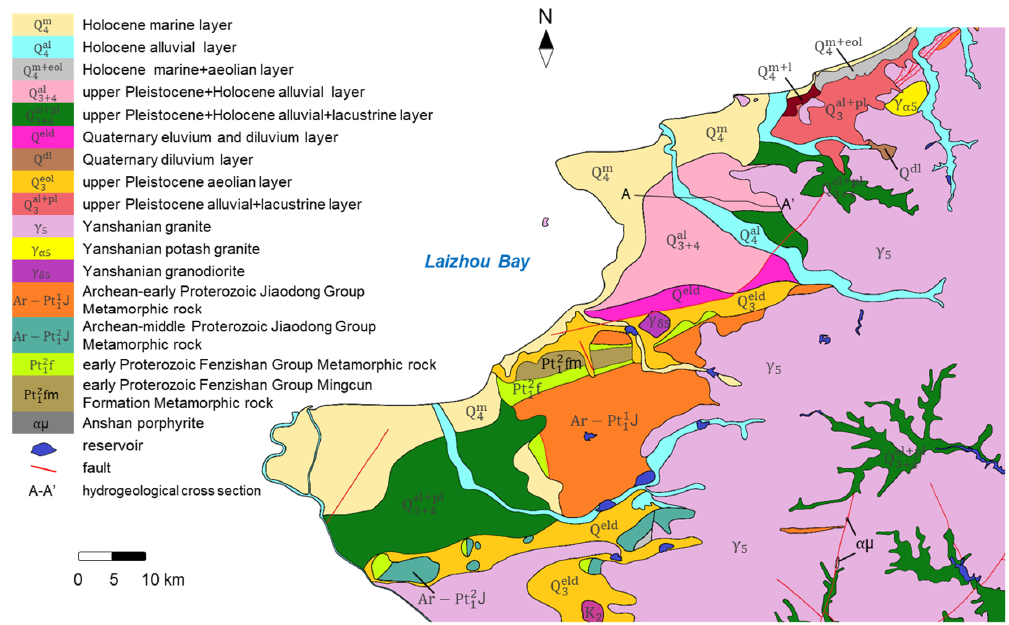
Figure 3. Geological map of the study area.